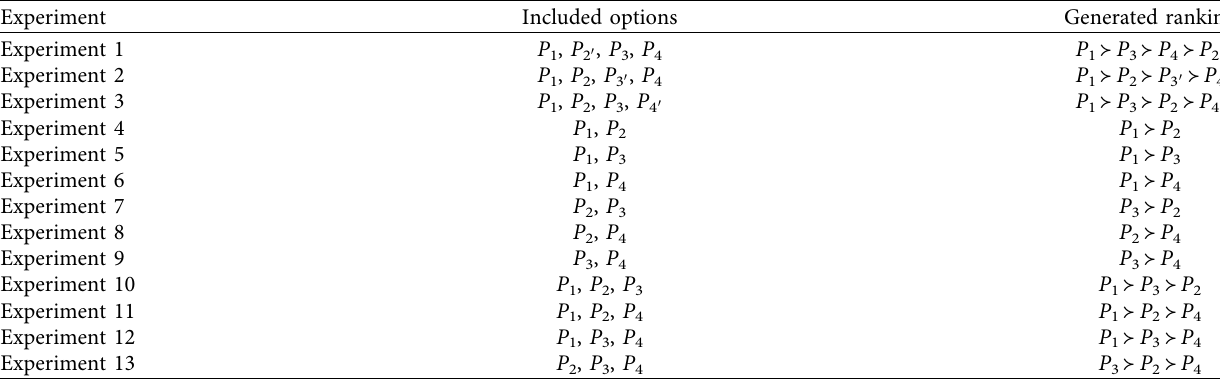
Table 1: The details and results of the validation experiments.